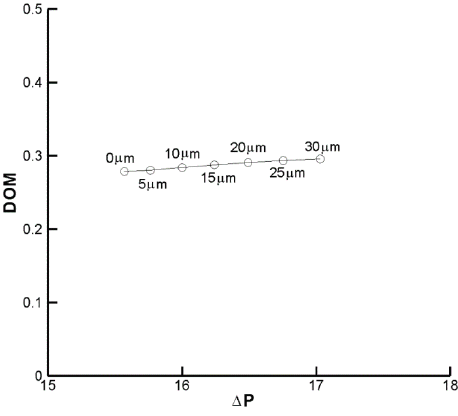
Figure 3. Effects of baffle thickness on the